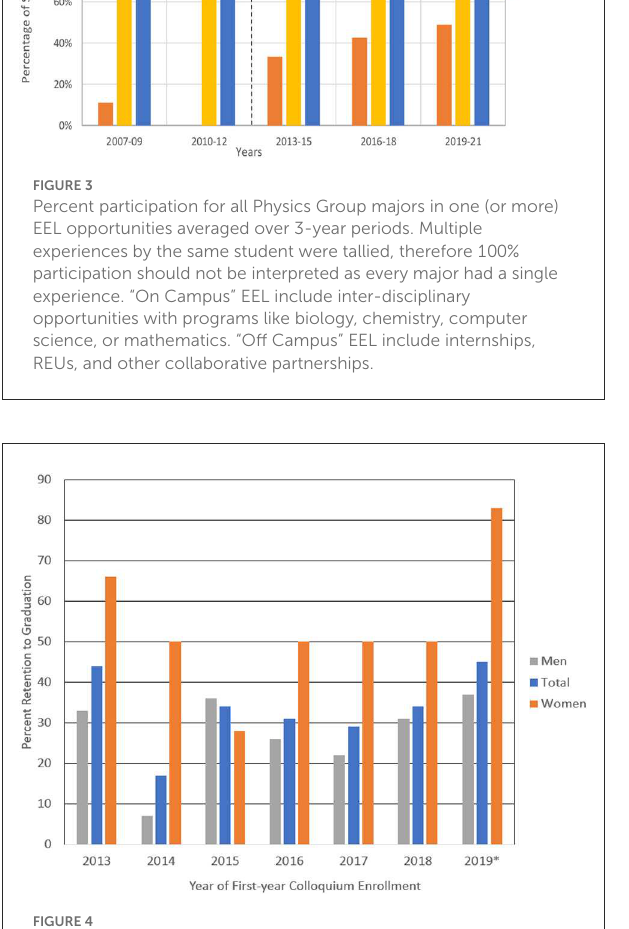
FIGURE4 Retention-to-graduation within the Physics Group for participants in the first-year colloquium by gender. The percentages are based on final enrollments in colloquium and final numbers of degree recipients. The asterisk for 2019 indicates those who had not officially graduated before the completion of the study. Their retention was calculated after the third-year of completion.